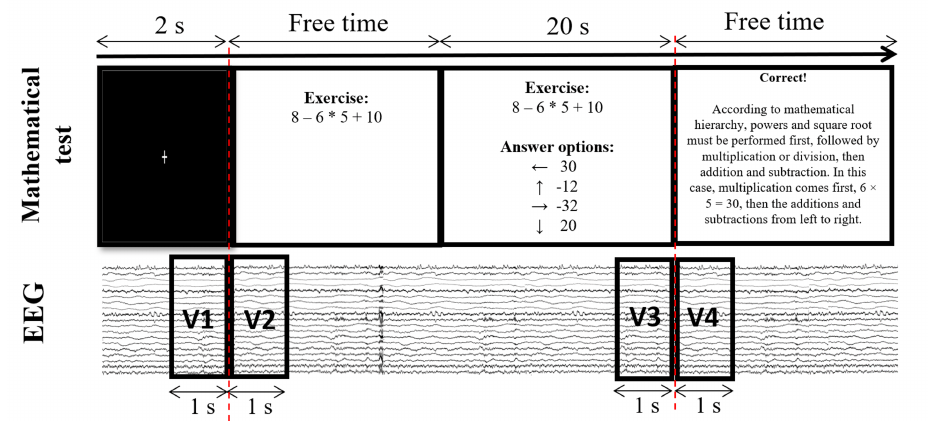
Figure 5. Mathematical exercise and structure of the windows of analysis. Representation of the selection of the 1-s windows of EEG recording in a simultaneous visualization of the math task. V1 represents the EEG recording window before viewing the mathematical approach, V2 corresponds to the window of the first instant of the display of the approach on the screen, V3 is the window of the instant of response selection, and V4 contains the feedback when the participant learned whether the response given was correct or incorrect (V1–V4 have a duration of 1